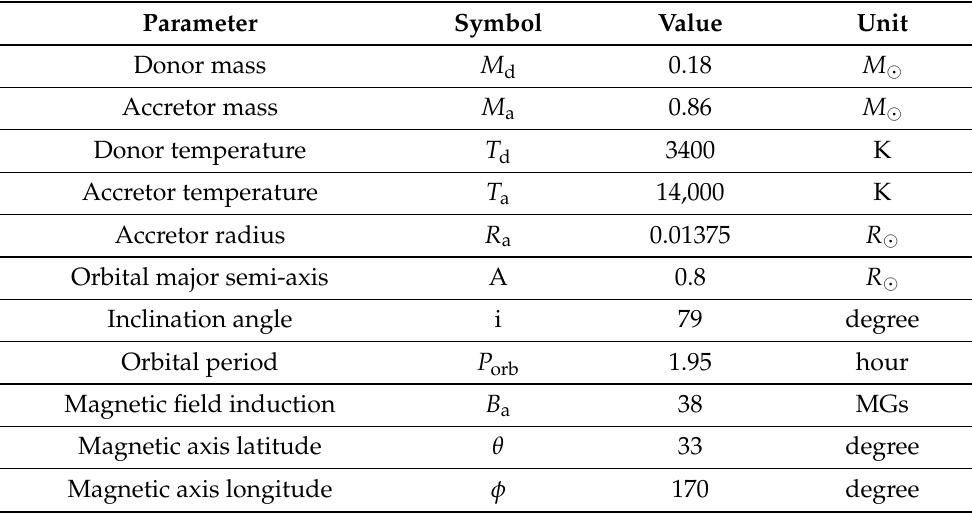
Table 3. The initial data of calculations for synchronous polar V808